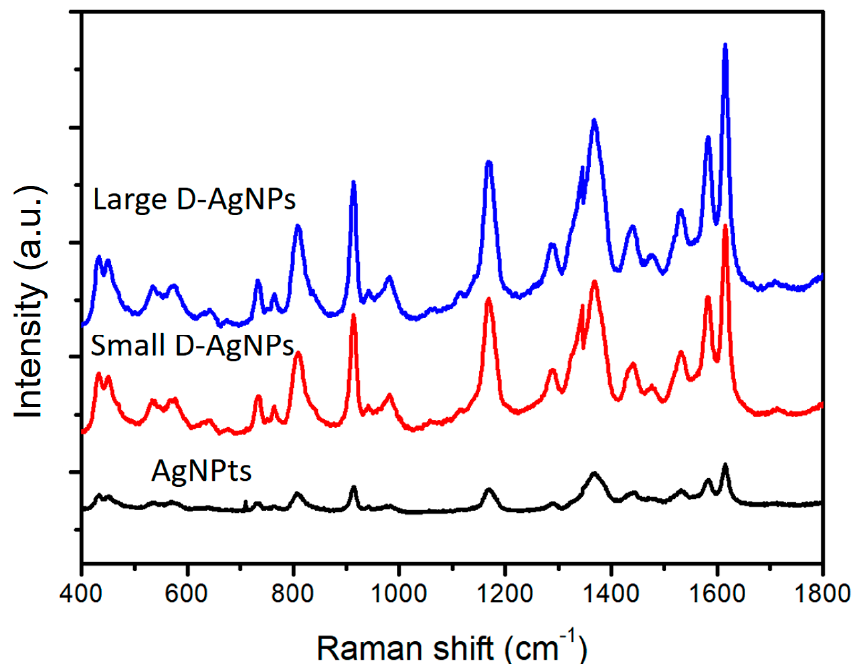
Figure 12. SERS spectra of 1 × 10 − 6 M crystal violet (CV) excited with a 532 nm laser (25 mW/cm 2 ) in AgNPr colloids (synthesized at 60 °C), small D-AgNP colloids (synthesized at 0 °C and reconstructed at 60 °C), and large D-AgNP colloids (synthesized at 0 °C and rebuilt at 60 °C and followed by an enlargement process under irradiation of green LEDs).